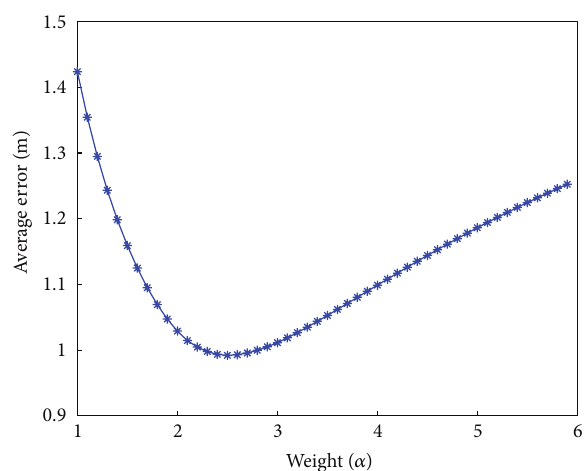
Figure 11: The dependence of weighting value on the average location estimation error for path 2.